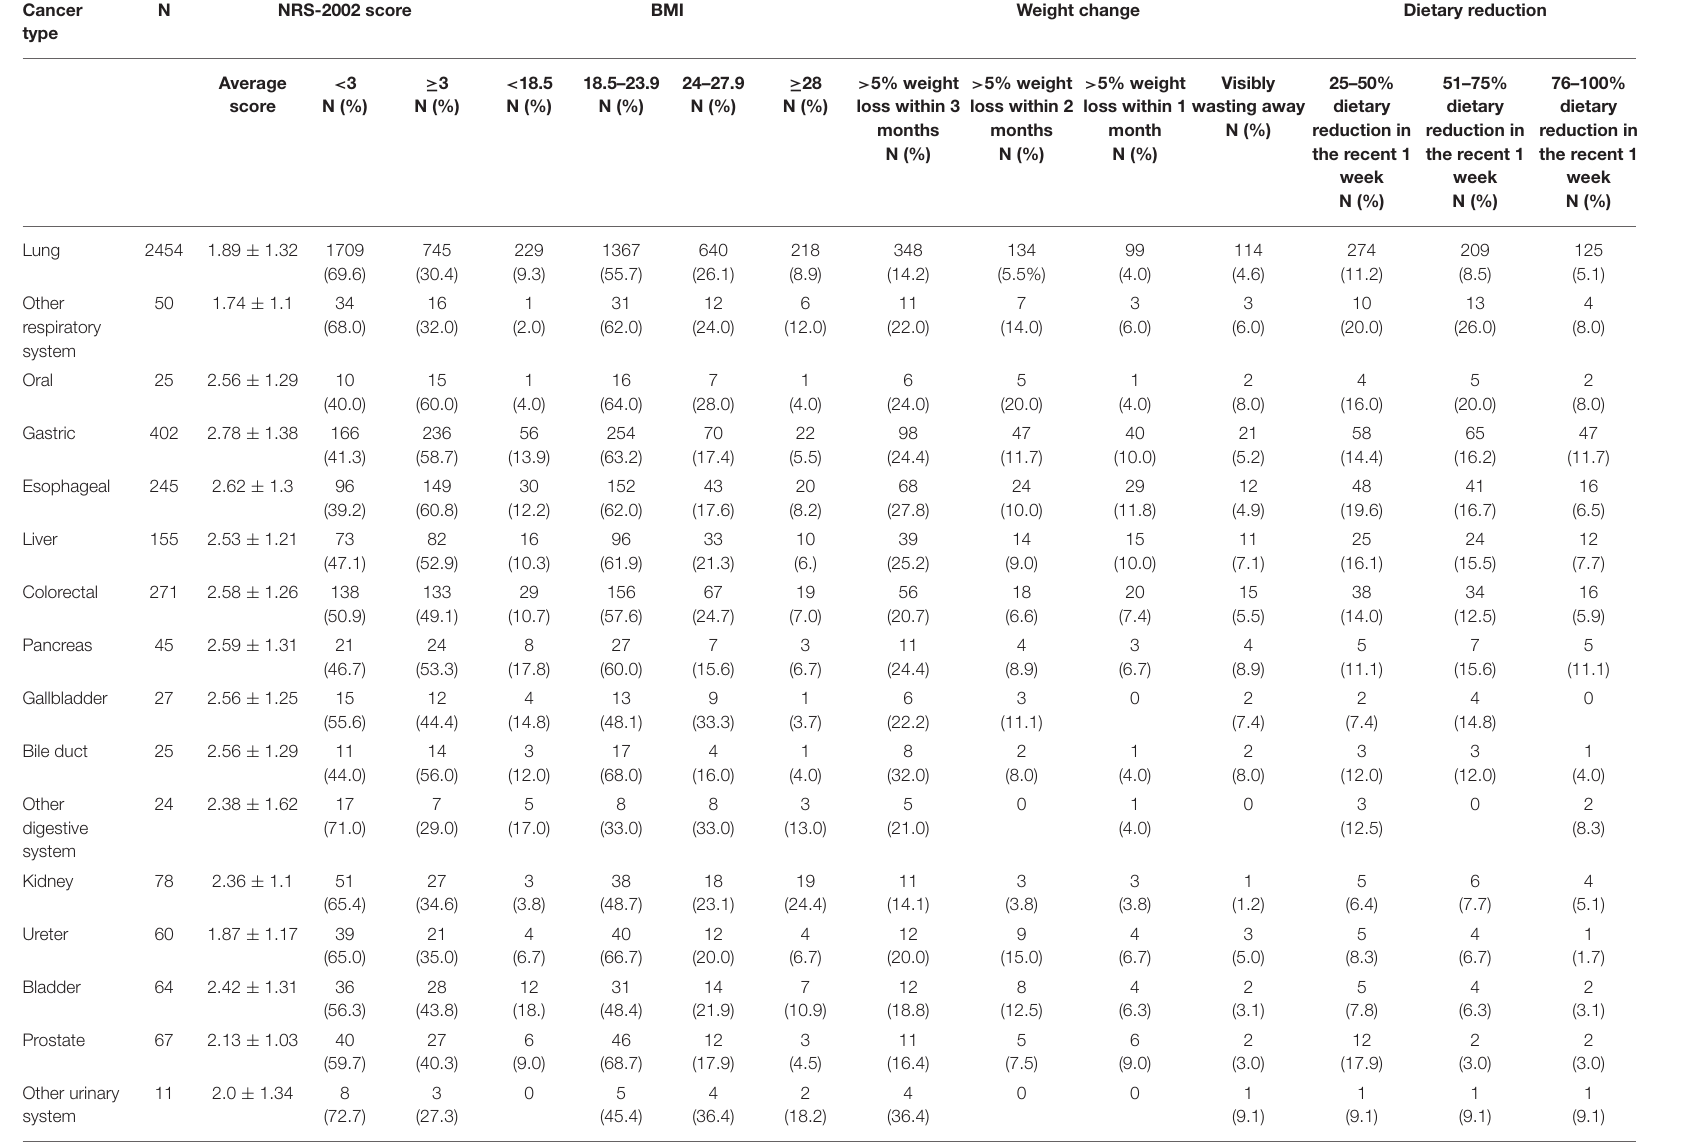
TABLE 1 | BMI, weight, and dietary reduction, NRS-2002 score of the